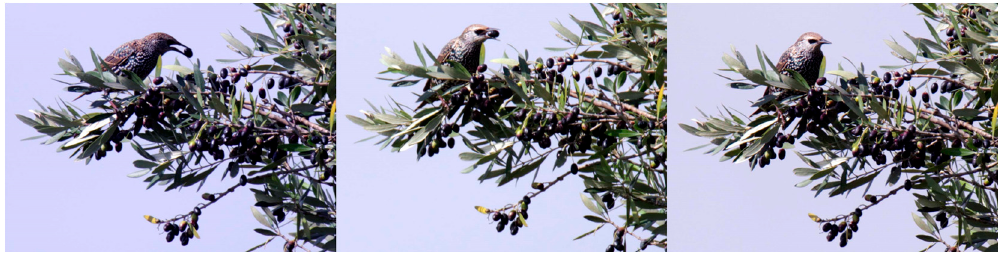
Figure 1. A starling eats an olive on a tree (ph. La Gioia ,